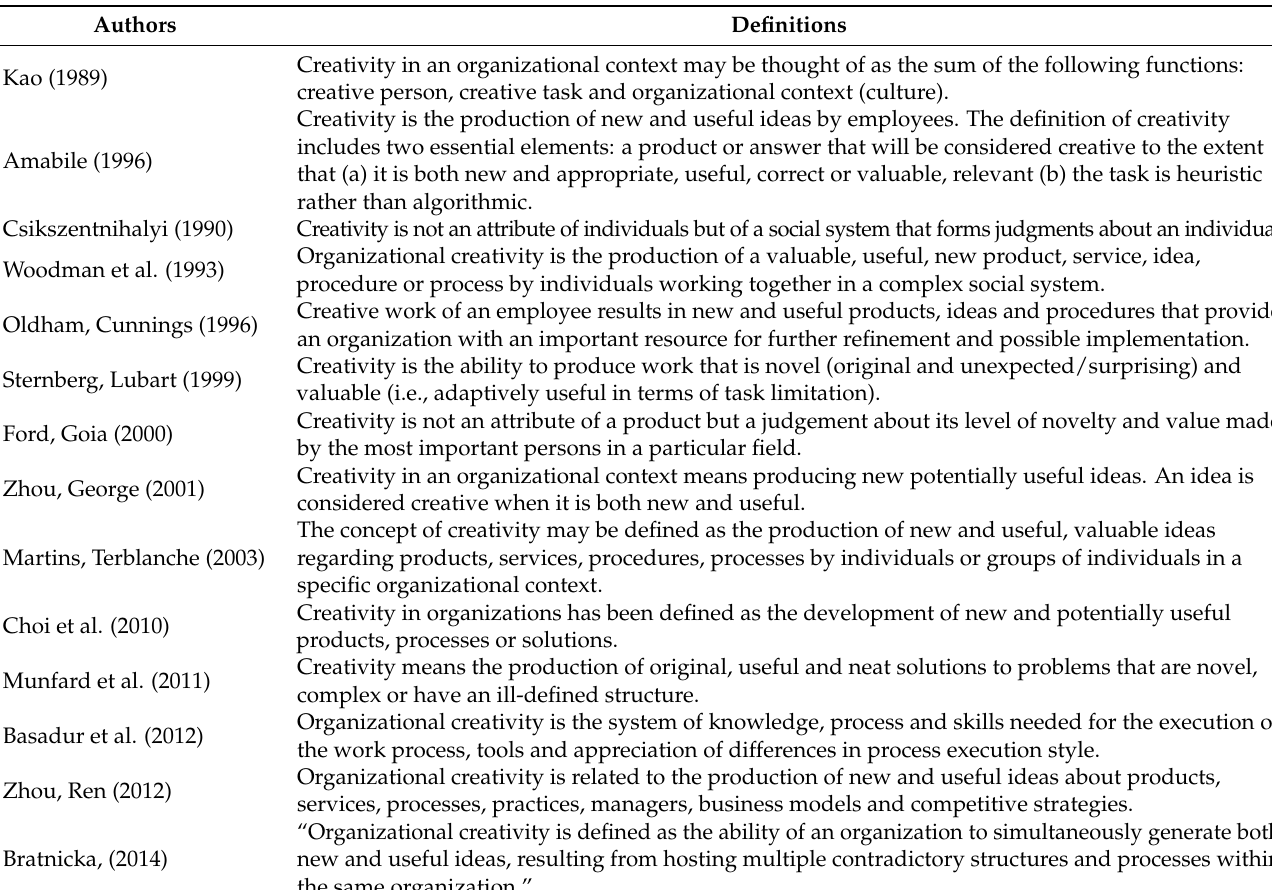
Table 1. The concept of organizational creativity—a review of selected source literature. Authors